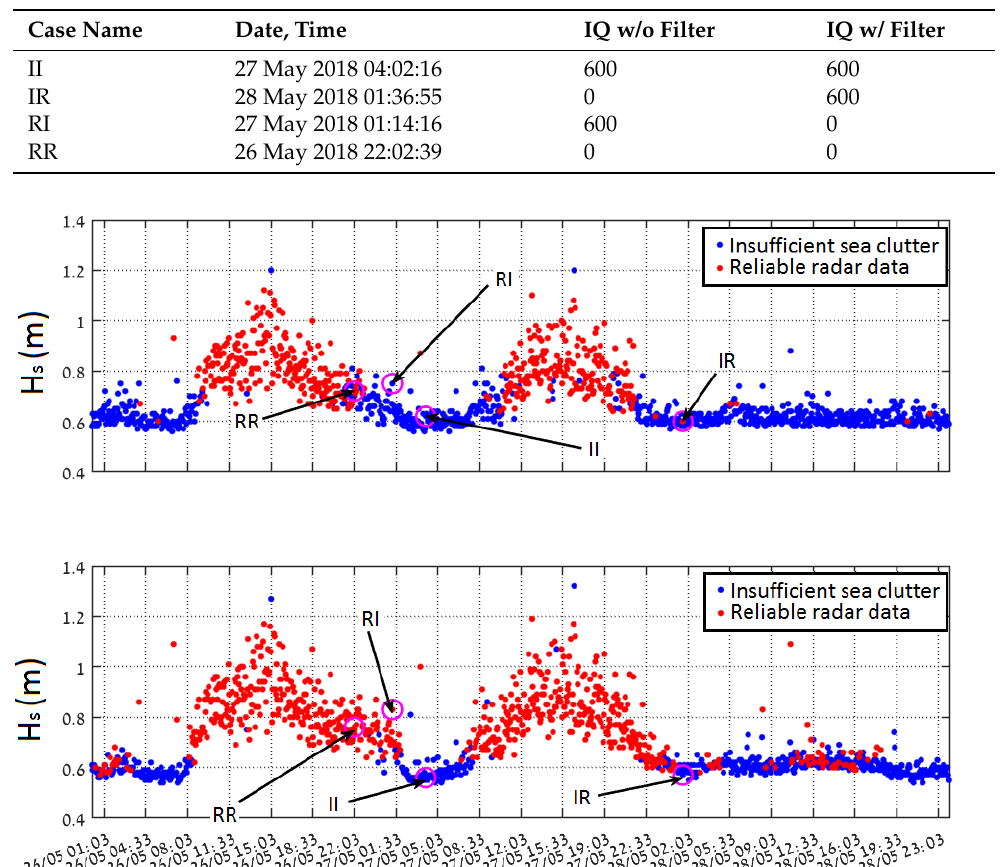
Figure 10. Comparison of the radar image sequence derived H s , calculated for the analysis box 2 and the corresponding wave rider buoy measurements for the mentioned period of the storm event before ( upper panel ) and after ( lower panel ) the streak filtration procedure. All the special cases, such as (II), (IR), (RI), and (RR) are marked in the time series (for the description of the cases refer also to the Table